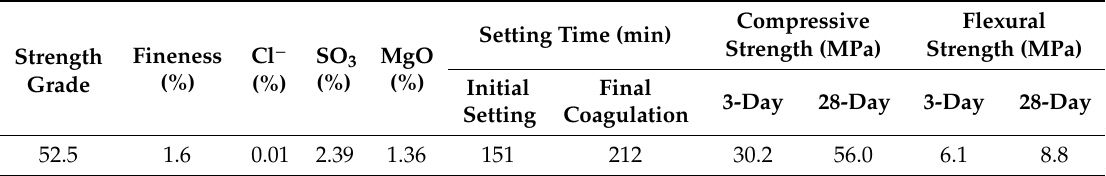
Table 2. Performance index of 52.5 grade Portland cement.